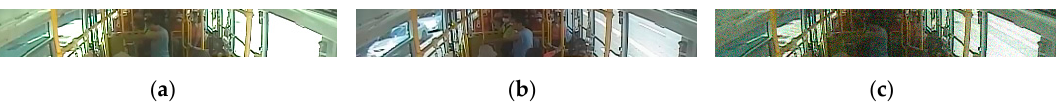
Figure 4. Crowded area definition.